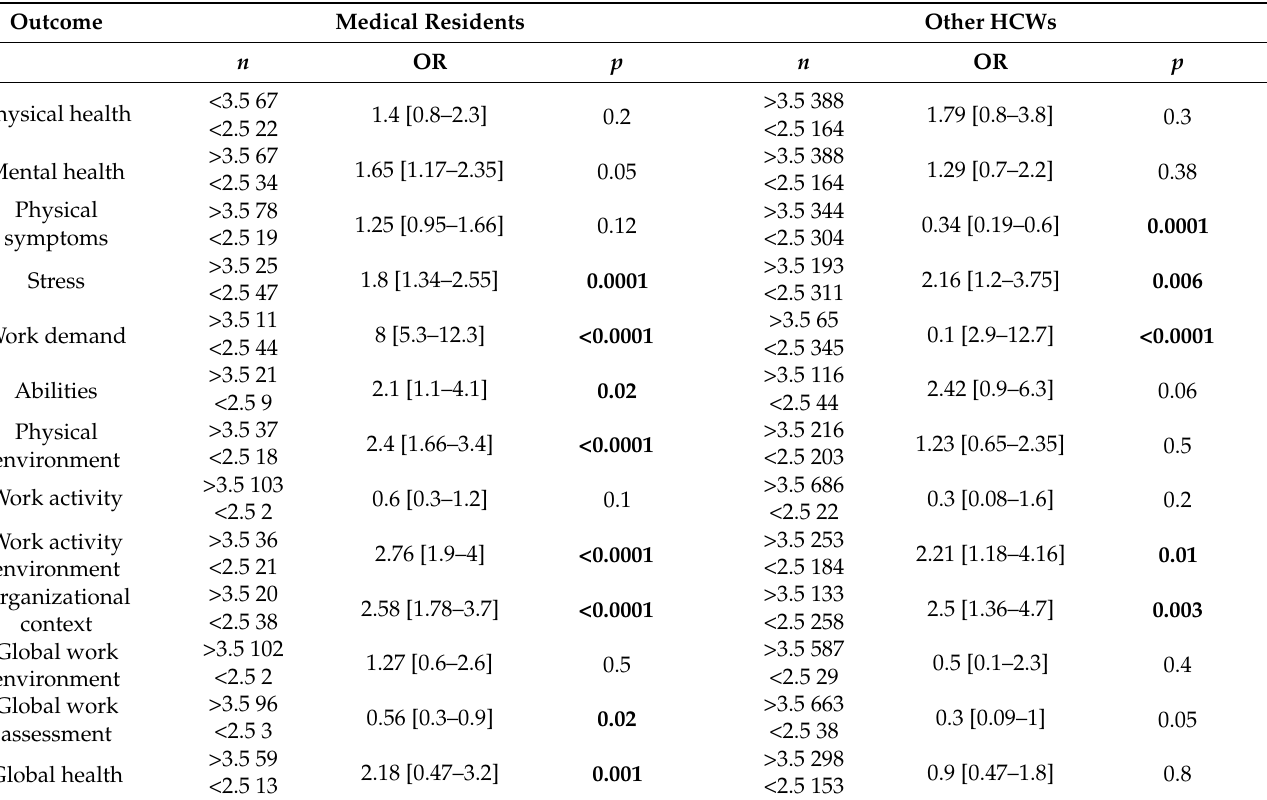
Table 2. Univariate analysis. Associations between risk factors and outcomes are presented as odds ratio and 95% confidence intervals.